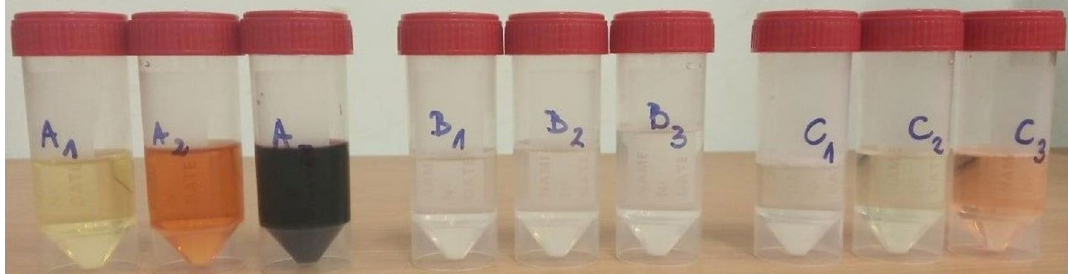
Figure 4. Solutions obtained after the extraction of heavy metals from the samples of leathers A1–A3, artificial leathers B1–B3 and textiles C1–C3. Source: Author’s own